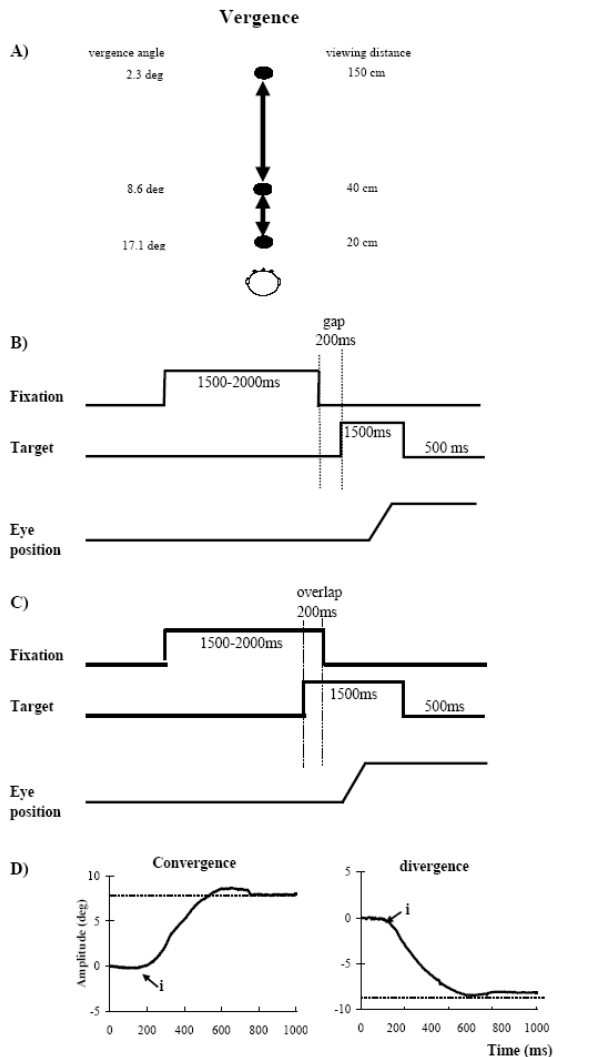
Figure 1. (A) Three LEDs (light emitting diodes) along median line were place on the horizontal table at 20cm, 40cm and 150cm in front of subject for eliciting convergence and diver- gence. (B) The paradigm used for the gap condition, the central fixation point disappears 200 ms before the appearance of the eccentric target. (C) For the overlap condition, the central fixa- tion point remains illuminated when an eccentric target appears. (D) Typical recordings of vergence are obtained by difference of the position signal of the two eyes LE-RE. The arrows at ‘i’ indicate the onset of